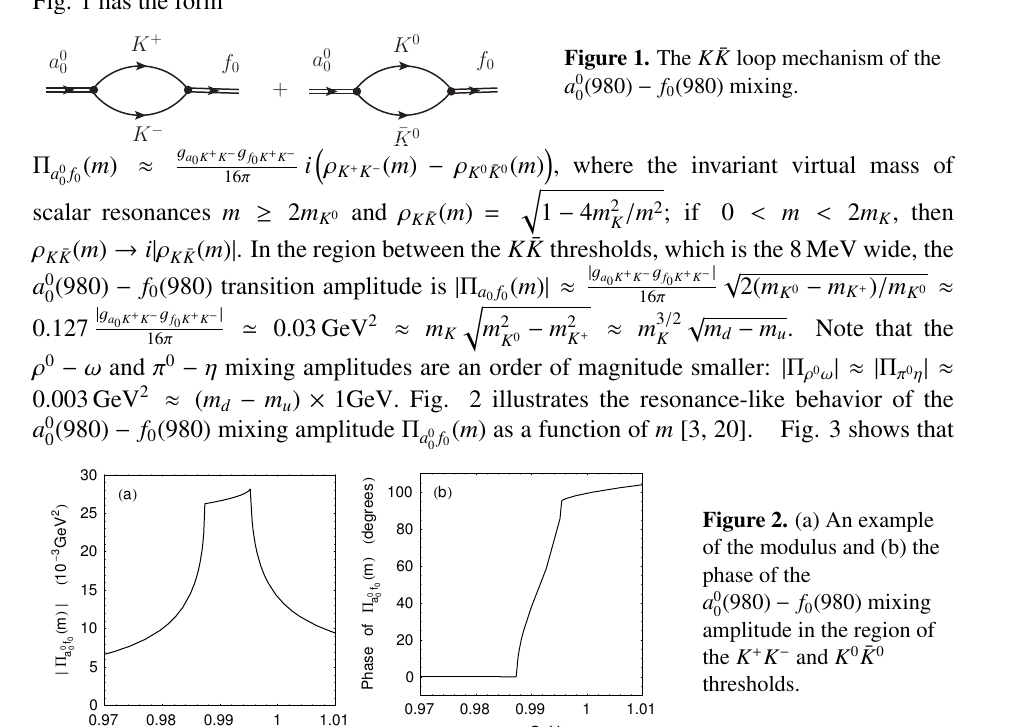
Figure 3. Mass spectra in the isospin-violating decays f 0 (980) → ηπ 0 and a 0 (980) → π + π − , caused by the 0 a 0 (980) − f 0 (980) mixing. They are the integrands in the 0 equations: BR ( f 0 (980) → K ¯ K → a 0 (cid:82) Γ ( m ) × 2 m 2 a 0 0 → ηπ 0 π